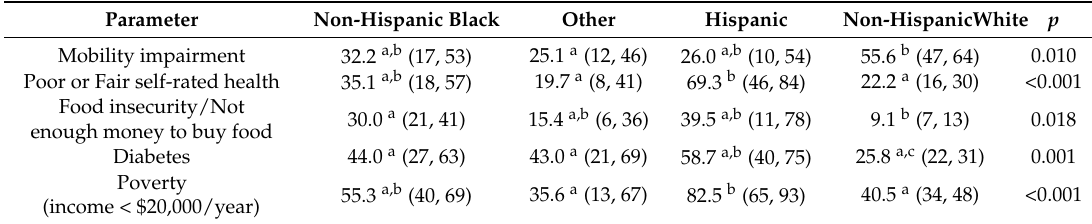
Table 3. Health-related characteristics with significant differences among races/ethnicities.